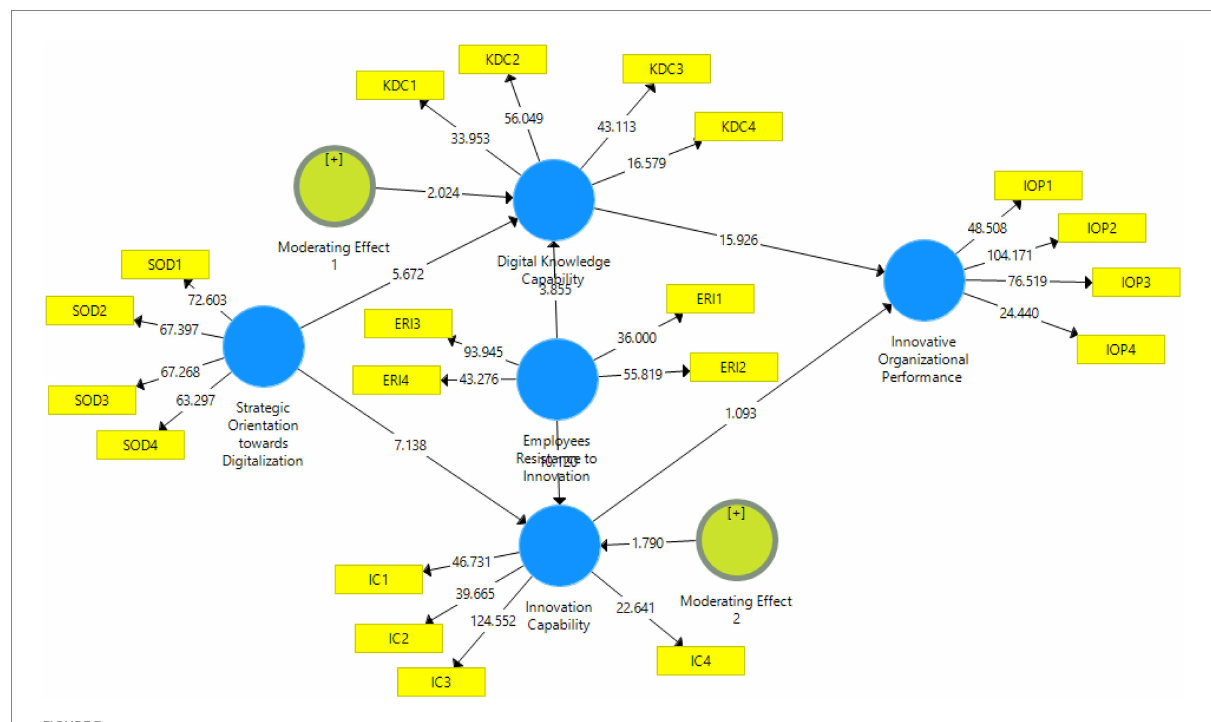
FIGURE 3 Structural model